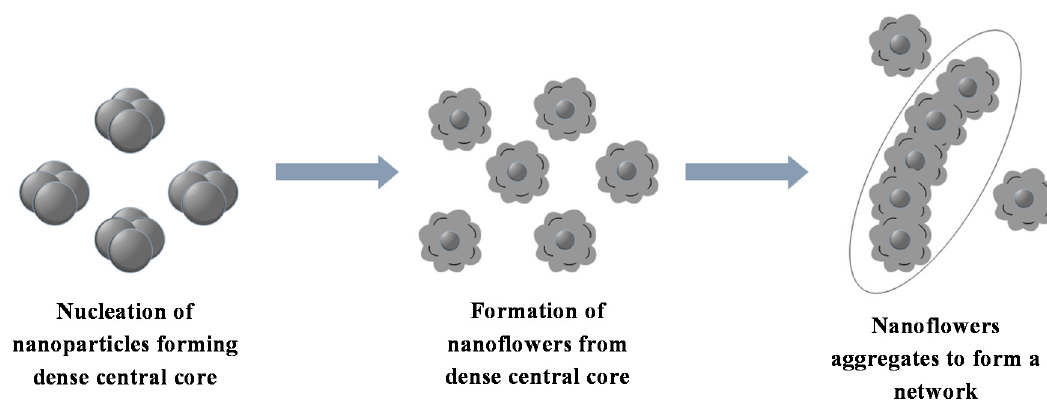
Scheme 2. Mechanism for the formation of MoSe 2 nanoflowers.